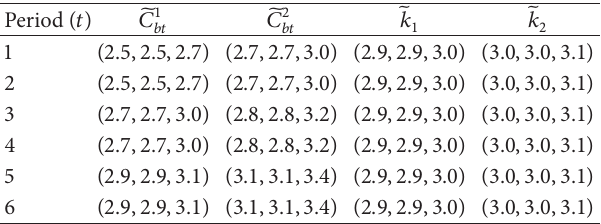
Table 6: Fuzzy unit backorder cost and conversion factor.